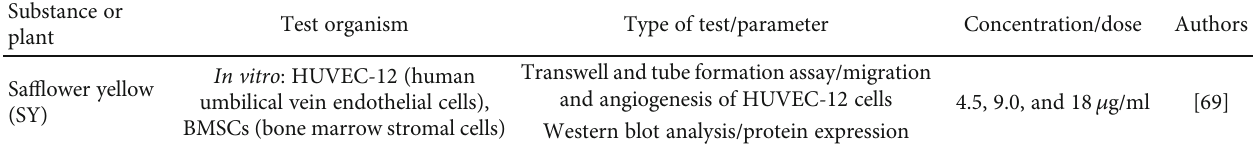
Table 4: Studies on the use of the substances contained in sa ffl ower fl owers, except HSYA, for medical purposes (from 2018 to 2020). Substance